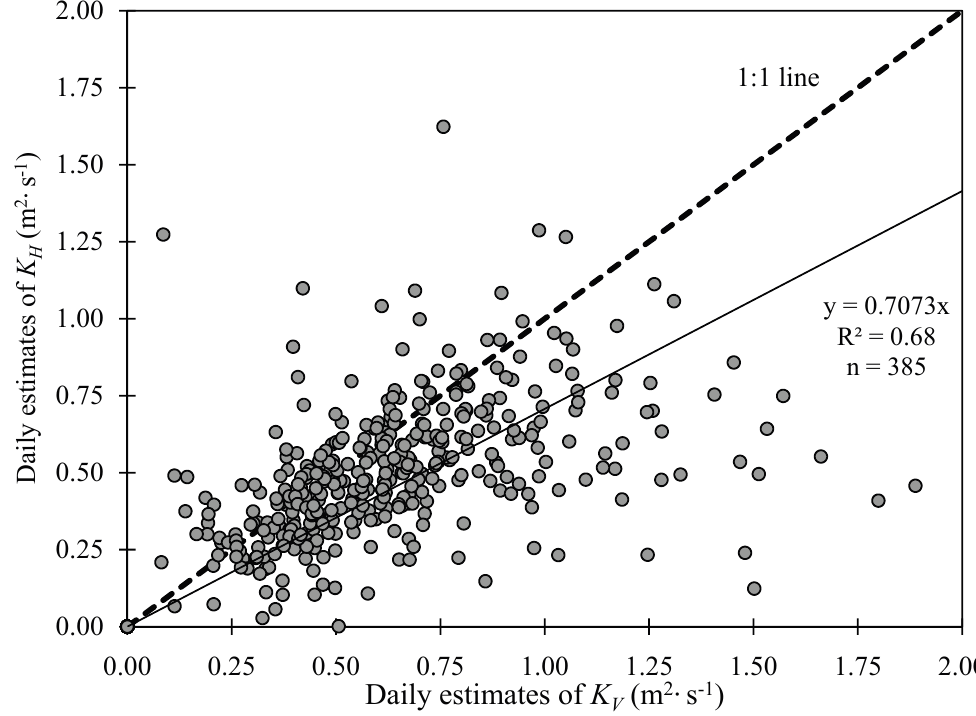
Figure 2. Daily estimates of K seasons in 2005 and 2006 (pooled data).